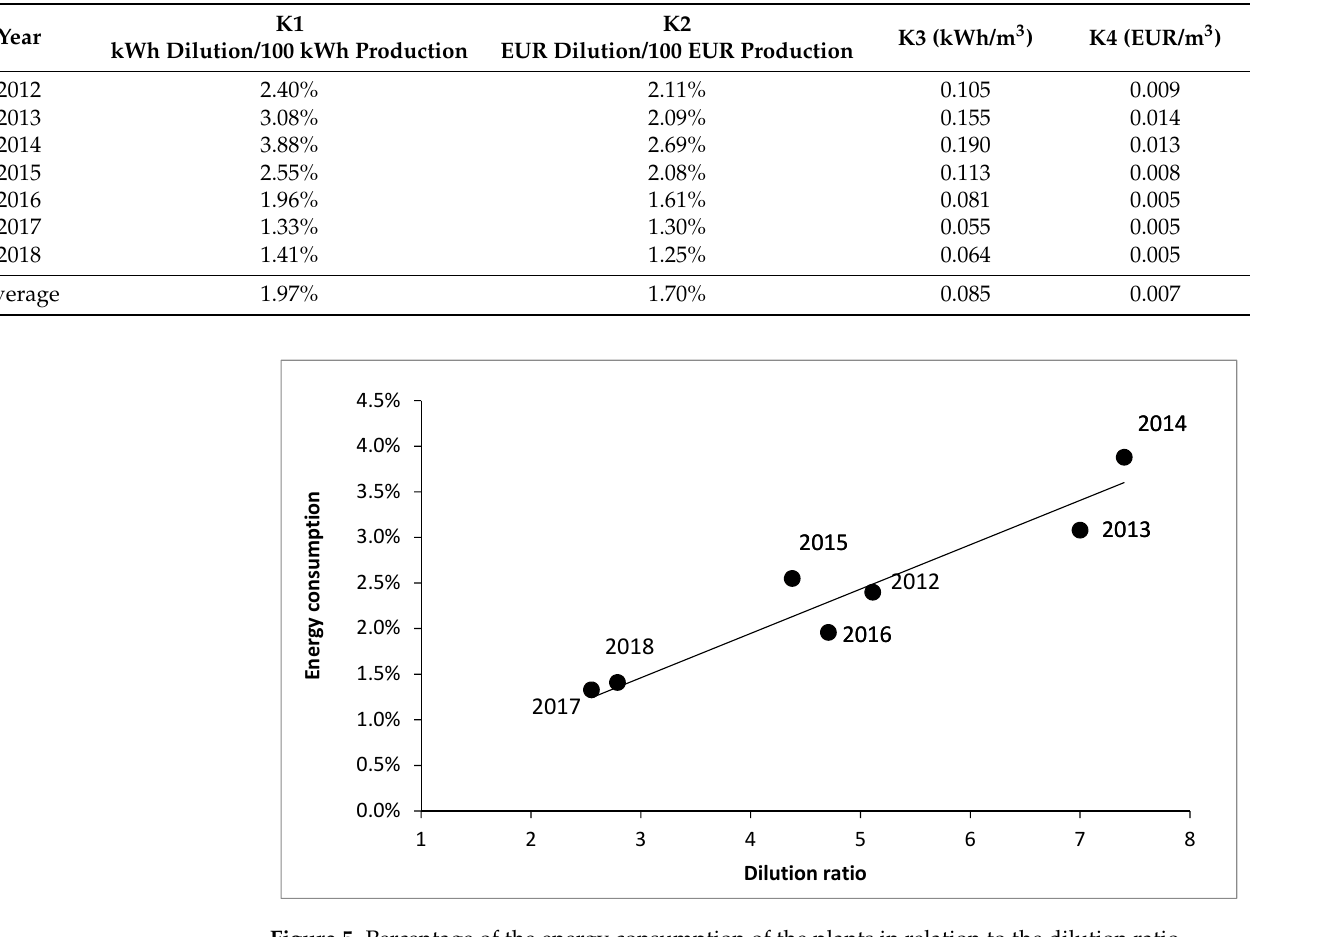
Table 2. Ratios between the energy consumption and dilution costs and between the total energy consumption and cost for both plants; K1 = kWh dilution versus total (kWh) electrical consumption in both plants (%); K2 = dilution cost (EUR) versus total electrical cost (EUR) in both plants (%); K3 = ratio between the consumed kWh dilution and the total water production of both plants (kWh/m 3 ); K4 = dilution cost (EUR) versus the total water production (EUR/m 3 ) (The maximum and minimum values are underlined.).